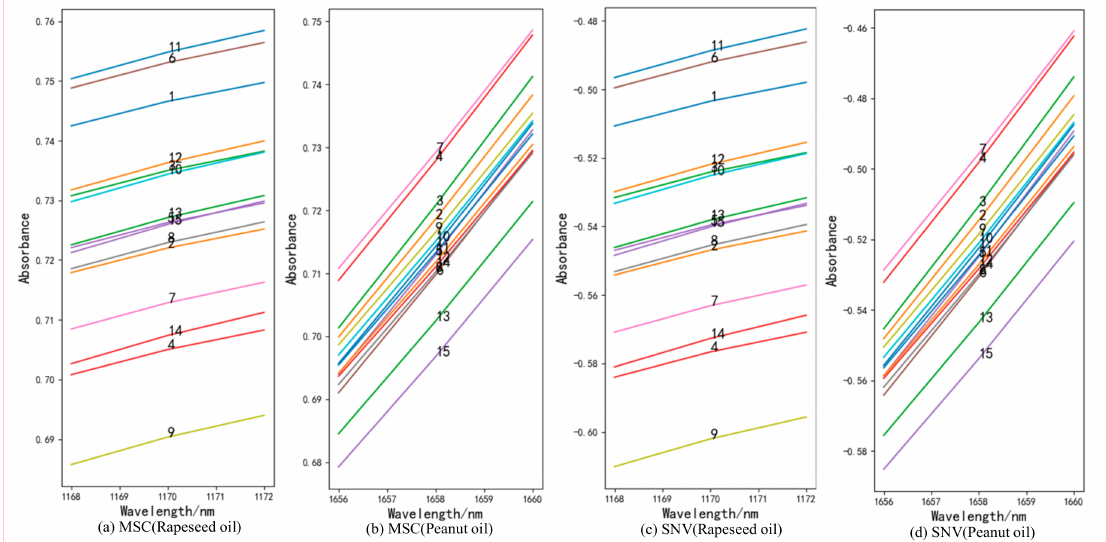
Figure 3. The frying times of peanut oil and rapeseed oil after multiplicative scatter correction (MSC) ( a , b ) and standard normal variant (SNV) ( c , d )